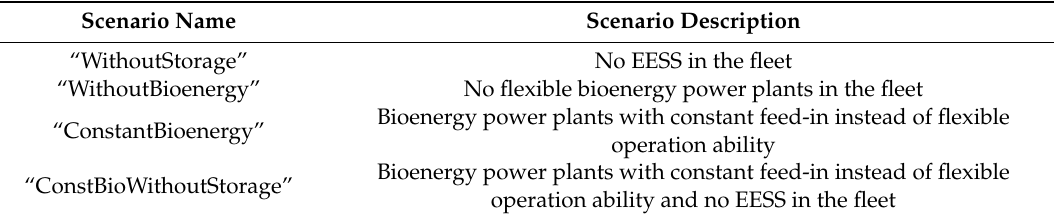
Table 5. Further scenarios for sensitivity analysis.